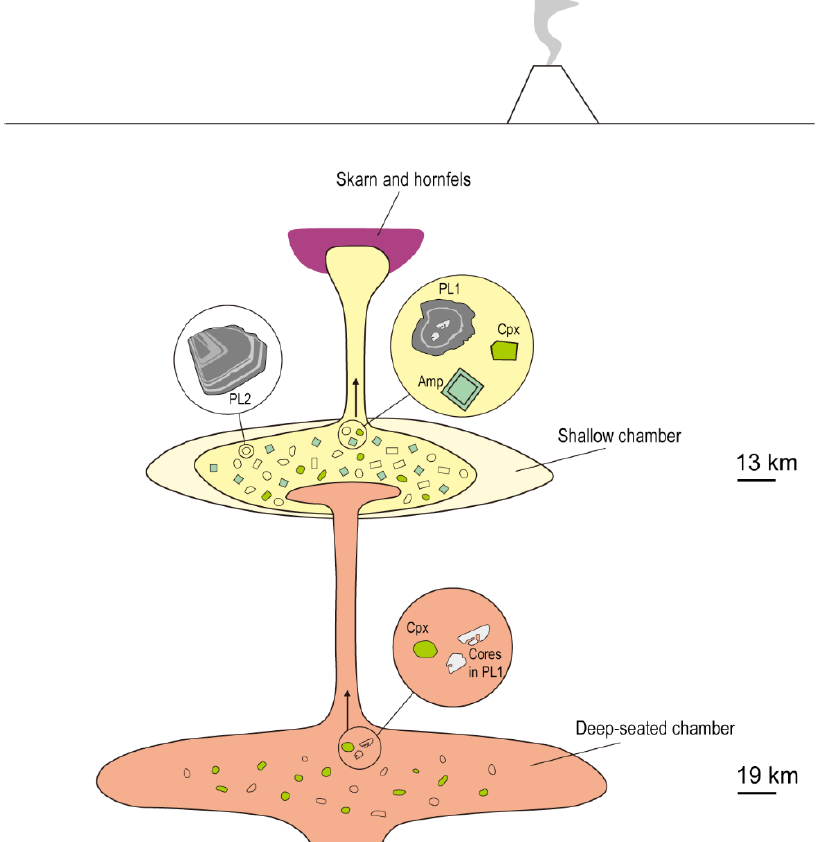
Figure 12. Magmatic system model for Hongniu-Hongshan deposit. Depths of magma chambers are estimated from the calculated pressure values of amphibole and clinopyroxene.